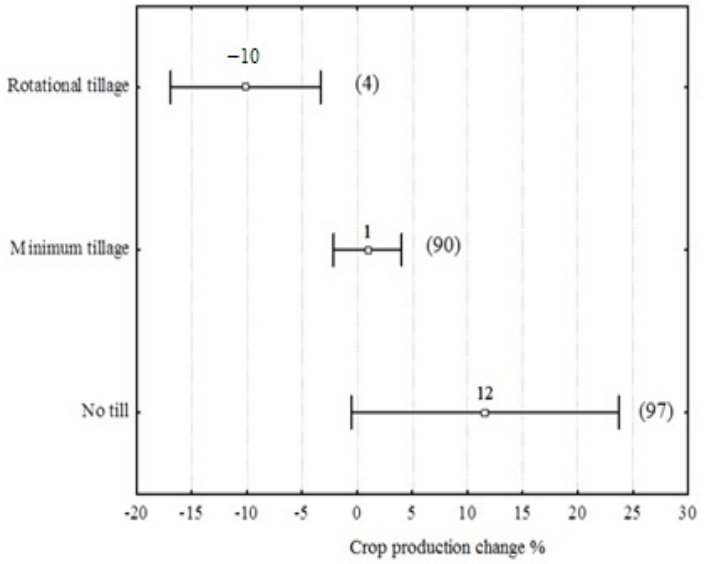
Figure 1. Mean plot of crop production change (%) in conservation tillage vs. conventional deep tillage grouped by tillage management. Box—Whisker plots represent central point means, and 95% confidence interval. Numbers in brackets represent the number of comparisons used in each category.